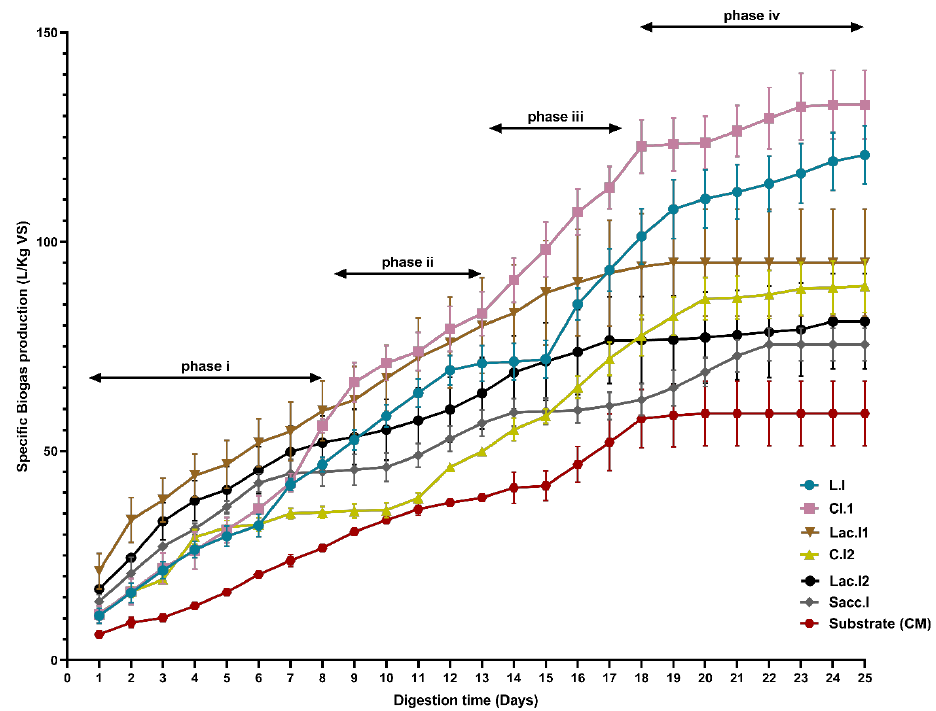
Figure 3. Cumulative Biogas yields various types of inocula in the anaerobic digestion process .